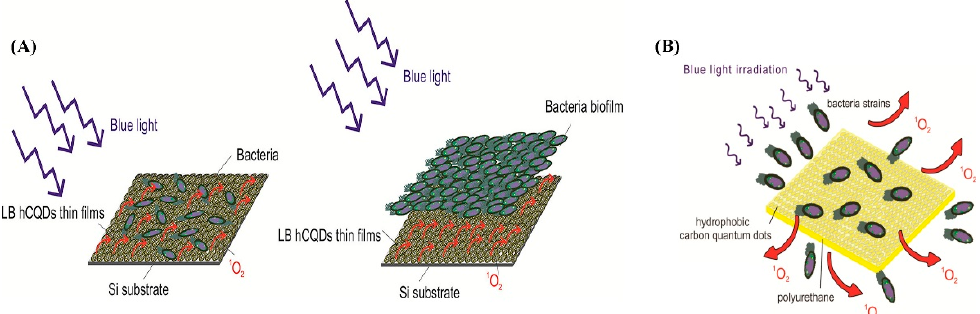
Figure 7. ( A ) Langmuir − Blodge tt (LB) hCQDs thin films for both antibacterial and anti-biofilm Figure 7. ( A )Langmuir −